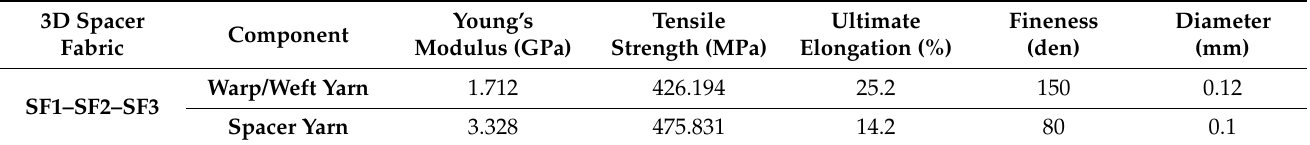
Table 4. Properties and geometries of various yarns of different 3D spacer